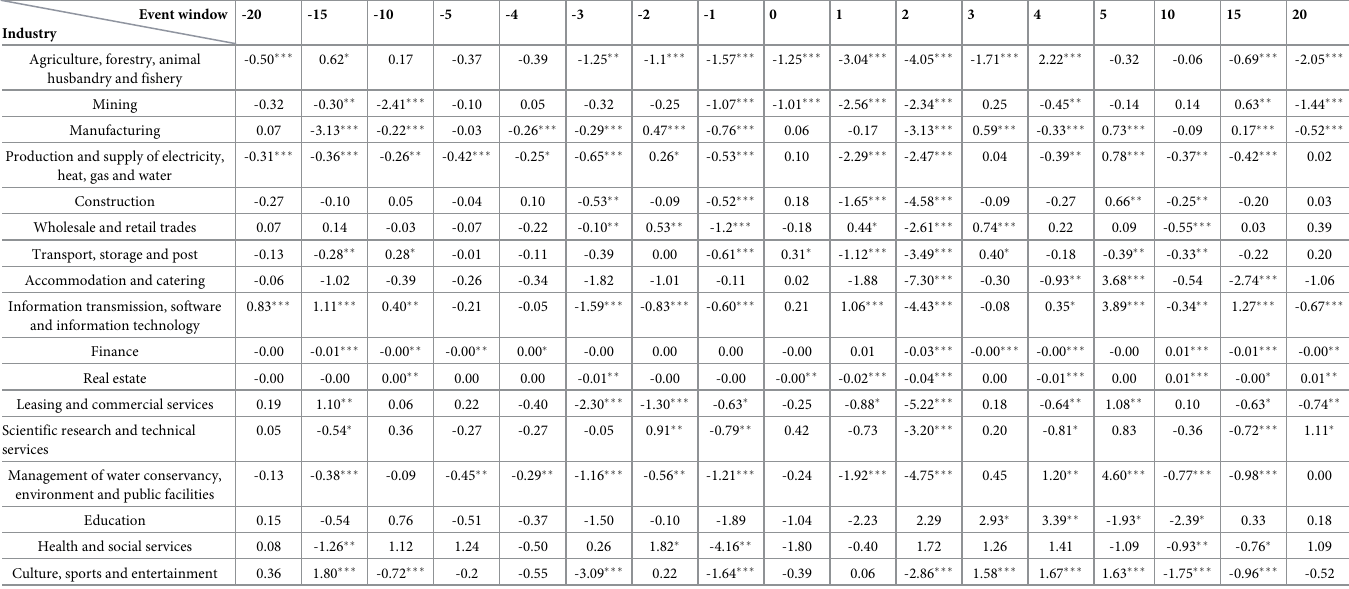
Table 1. Industry-specific AARs over the event